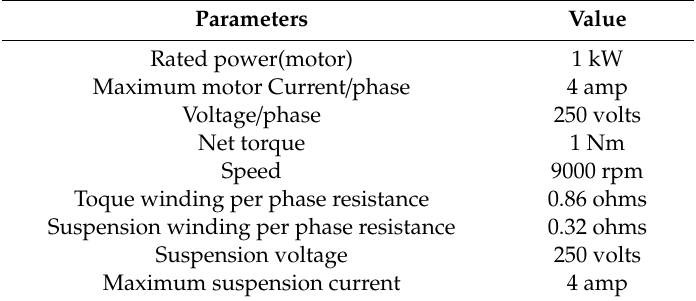
Figure 1. Structure and winding pattern of the stator. Table 1. Operating details of the 12/14 bearingless switched reluctance motor (BSRM).